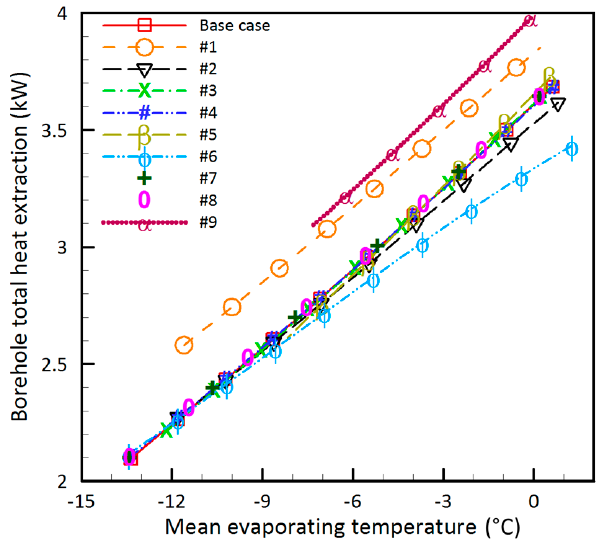
Figure 8. Gas cooler heating capacity ( q gc ).